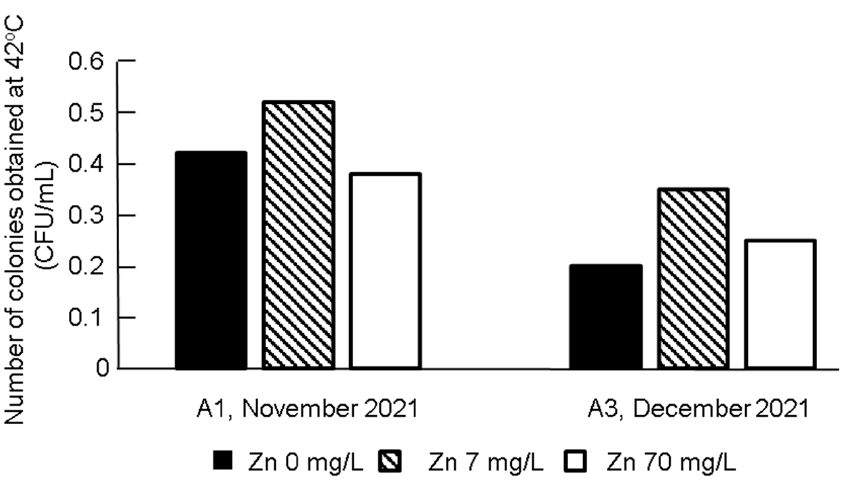
Figure 2. Effect of ZnSO 4 addition to meropenem-containing culture-medium on the number of colonies.